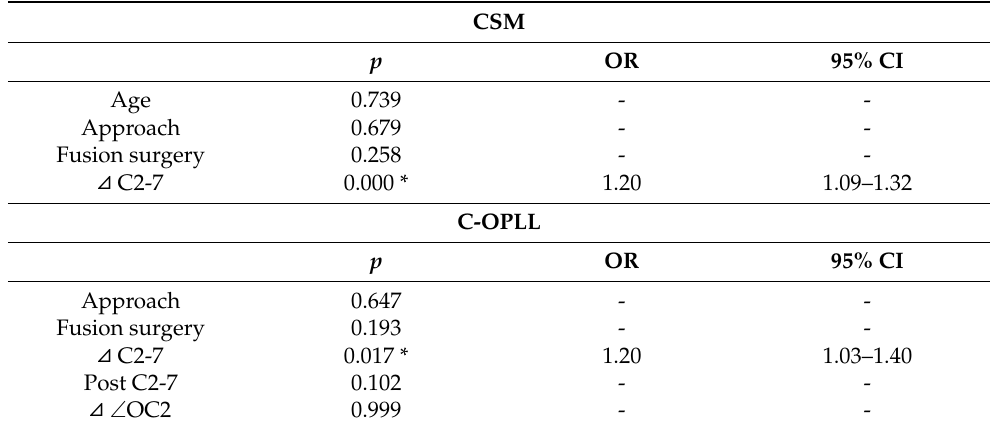
Table 7. Risk factors of new dysphagia at 1-year after surgery.